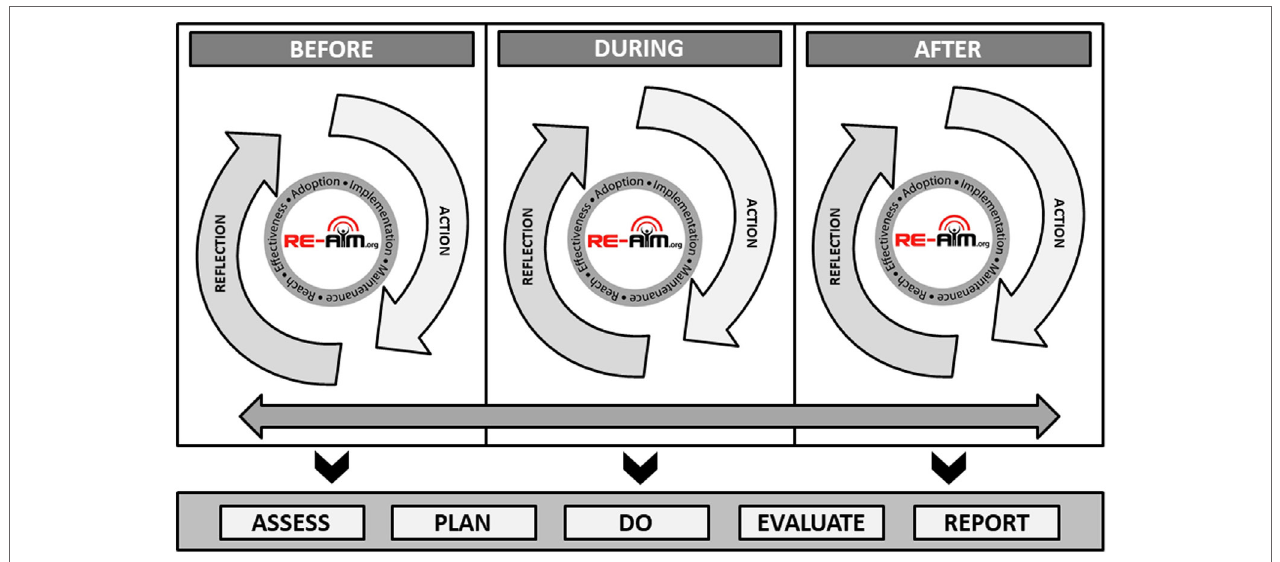
FiGUre 1 | Iterative and temporal application of the RE-AIM